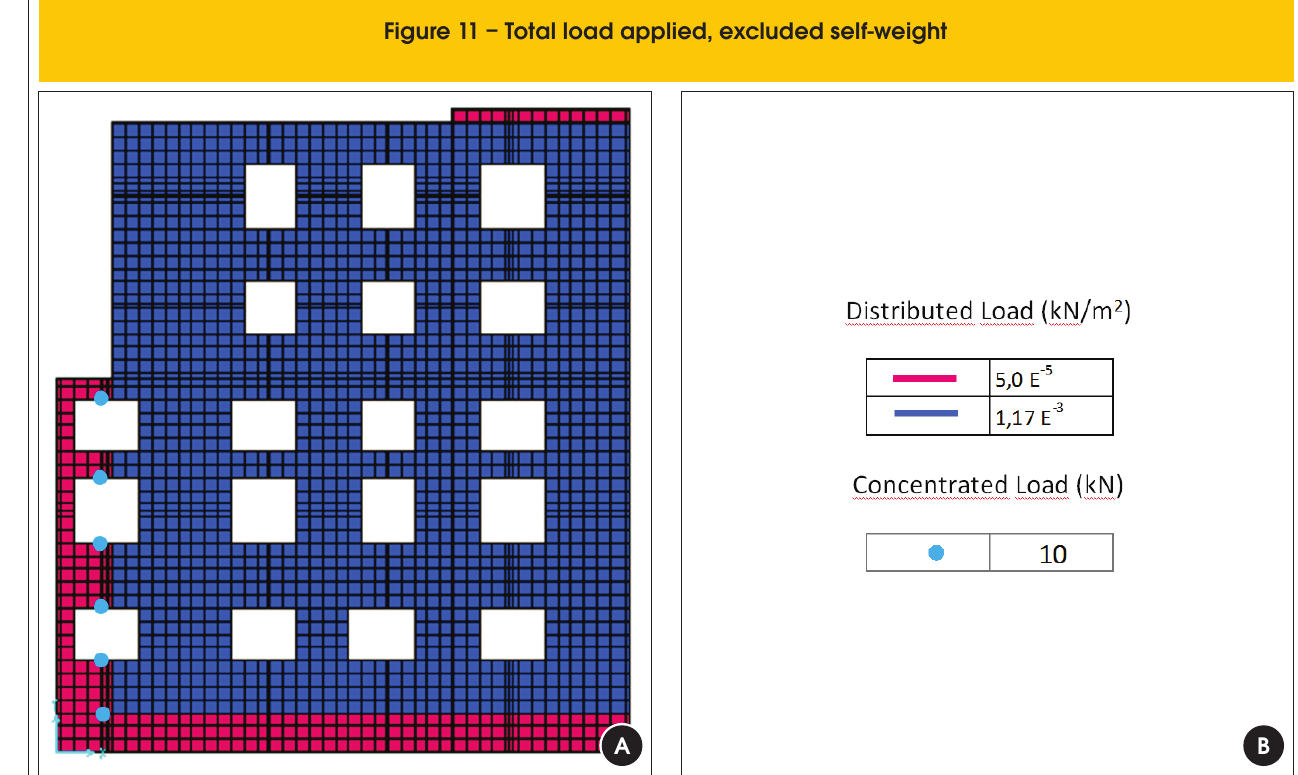
Figure 11 – Total load applied, excluded